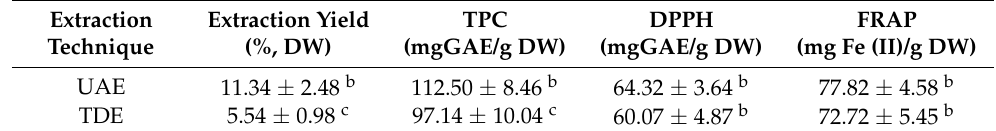
Extraction Yield